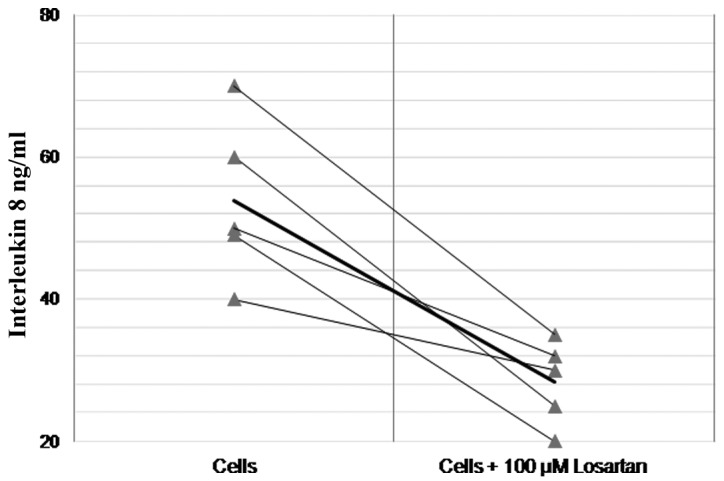
A graphic presentation of the impact of 100 μM of losartan on the interleukin-8 production of non-LPS- or angiotensin II-stimulated THP-1 cells. Each thin line represents an individual experiment. The bold line shows the mean values.